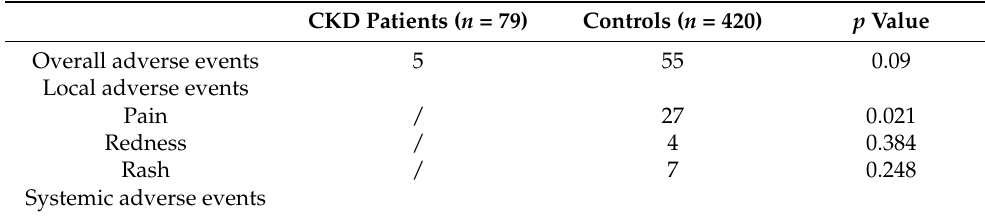
Table 4. Adverse events after SARS-CoV-2